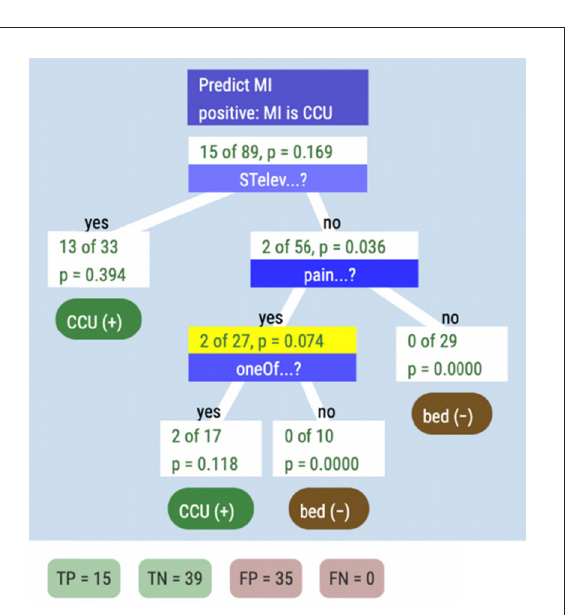
FIGURE14 The classification and decision tree based on three